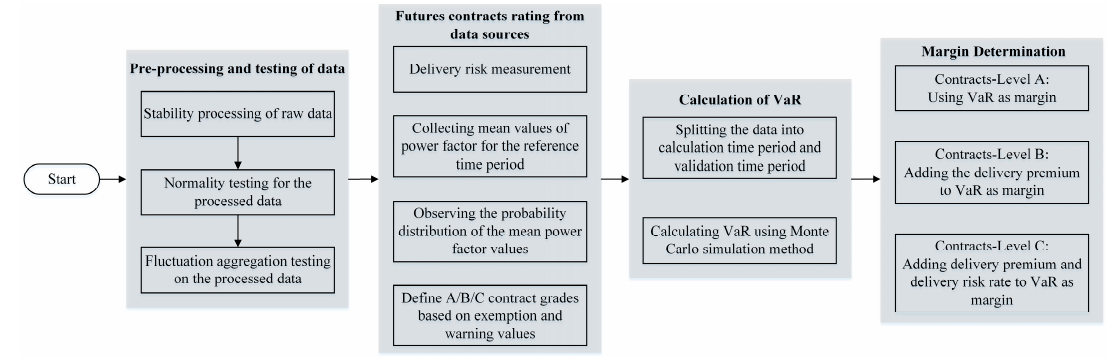
Figure 3. Step flow of empirical study.